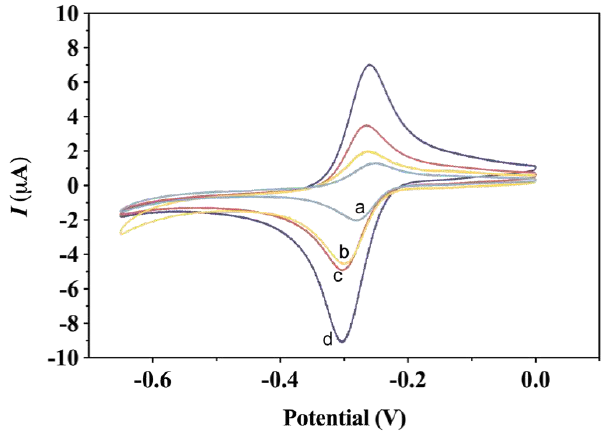
Figure 3. CV of electrode under each assembly procedure from − 0.65 to 0.00 V (scan rate: 100 mV / s): ( a ) bare electrode, ( b ) electrode modified with Co 2 Ti 1 , ( c ) electrode modified with Co 2 Ti 1 / aptamer, ( d ) electrode modified with Co 2 Ti 1 / aptamer / Cd 2 +